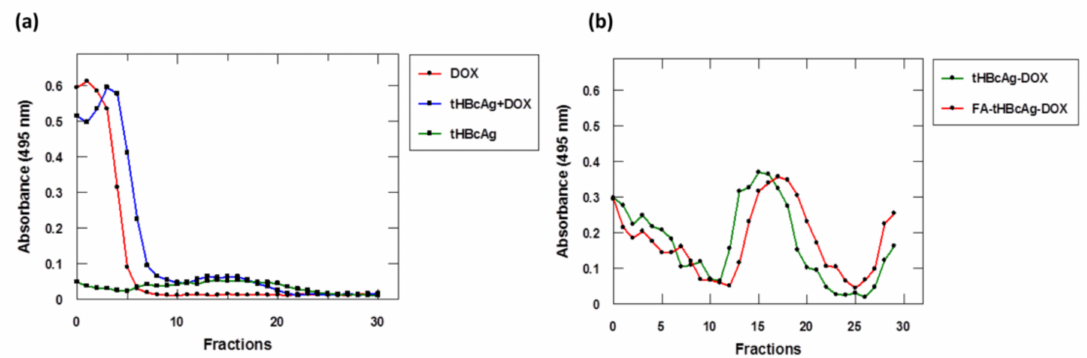
Figure 4. Detection of doxorubicin conjugated to tHBcAg VLNPs separated on sucrose gradients. The absorbance at 495 nm (A 495 ) of samples was measured with a spectrophotometer. ( a ) Doxorubicin (DOX), and the DOX added to tHBcAg without the conjugation procedure (tHBcAg + DOX) stayed on top of the sucrose gradients. tHBcAg VLNPs (tHBcAg), which served as a negative control, were not detected at A 495 ; ( b ) DOX-conjugated tHBcAg VLNPs (tHBcAg-DOX), as well as tHBcAg VLNPs conjugated with folic acid (FA) and DOX (FA-tHBcAg-DOX) migrated into the sucrose gradients, and the conjugated DOX was detected at A 495 .